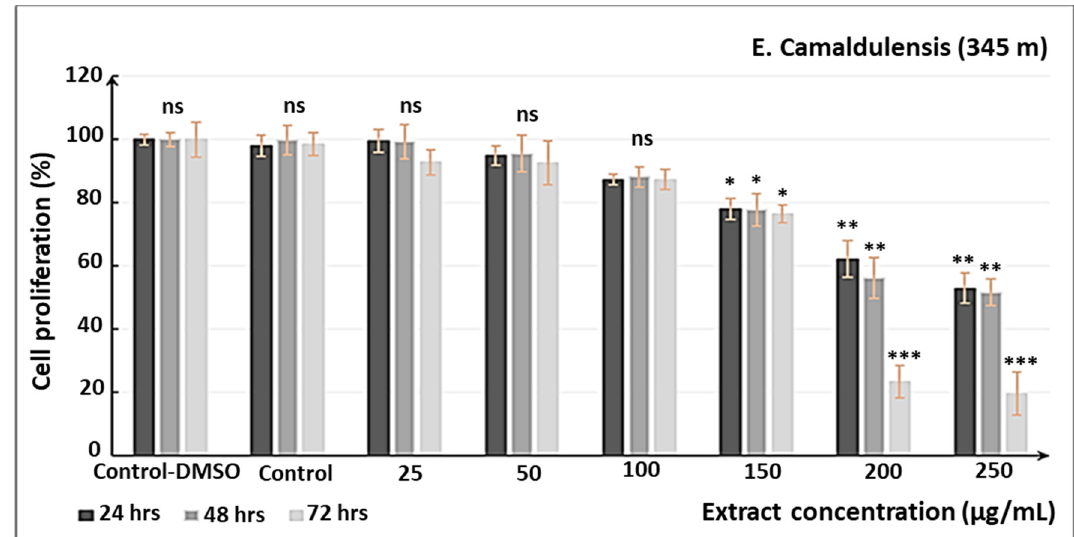
Figure 5. Cell viability of A549 cells after the exposure to ethanolic extract of E. camaldulensis (345 m) for 24, 48, and 72 h. Peak values are represented as mean +/ − SD. Statistical analysis: Paired t test or Wilcoxon test.* p < 0.05; ** p < 0.01; *** p < 0.001 in which percentage of proliferation of treated cells is compared with that of control-DMSO at 24, 48, or 72 h. ns refers to non-significant result.